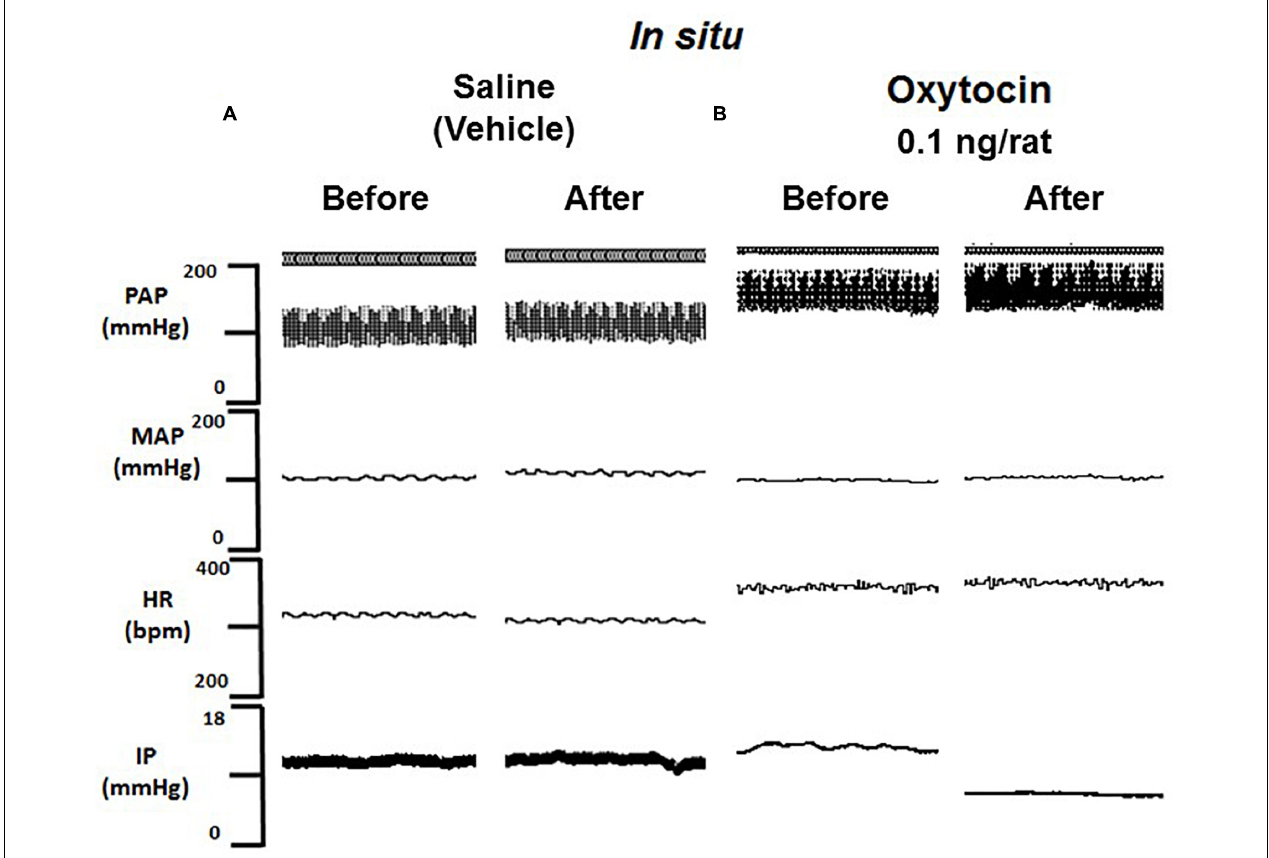
FIGURE 5 | Tracing showing pulsatile arterial pressure (PAP, mmHg), mean arterial pressure (MAP, mmHg), heart rate (HR, bpm) and intravesical pressure (IP, mmHg) before and after saline (A) or oxytocin 0.1 ng/rat (B) in situ administration on the outside of the urinary bladder in sham